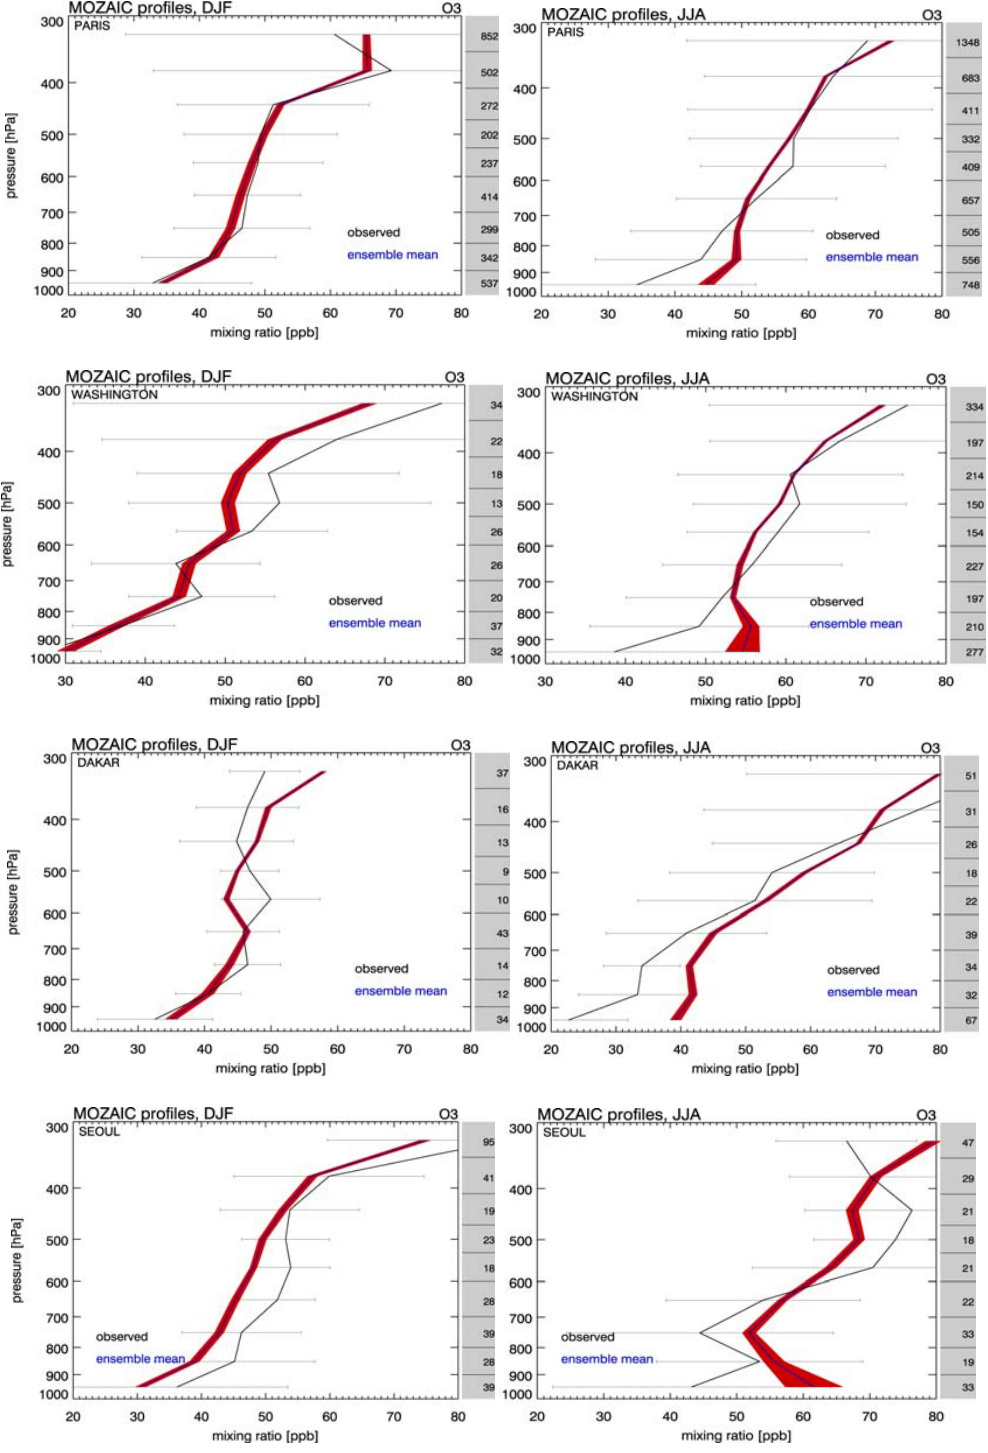
Fig. 5. Seasonal comparisons of tropospheric O 3 profiles measured as part of the MOZAIC measurement program against the 1- σ deviation (red) in the ensemble model mean from the TM5 simulations. The ensemble mean value is shown as the blue line. The error bars on the measurements represent the 1- σ deviation in the seasonal mean.